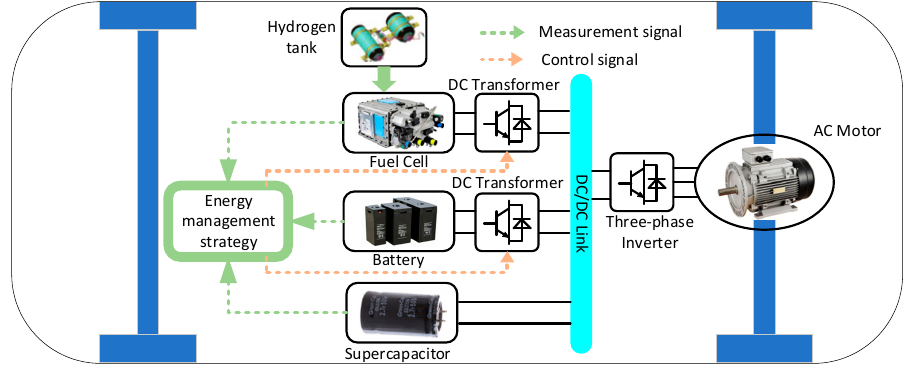
Figure 2. Schematic diagram of an FCEV.